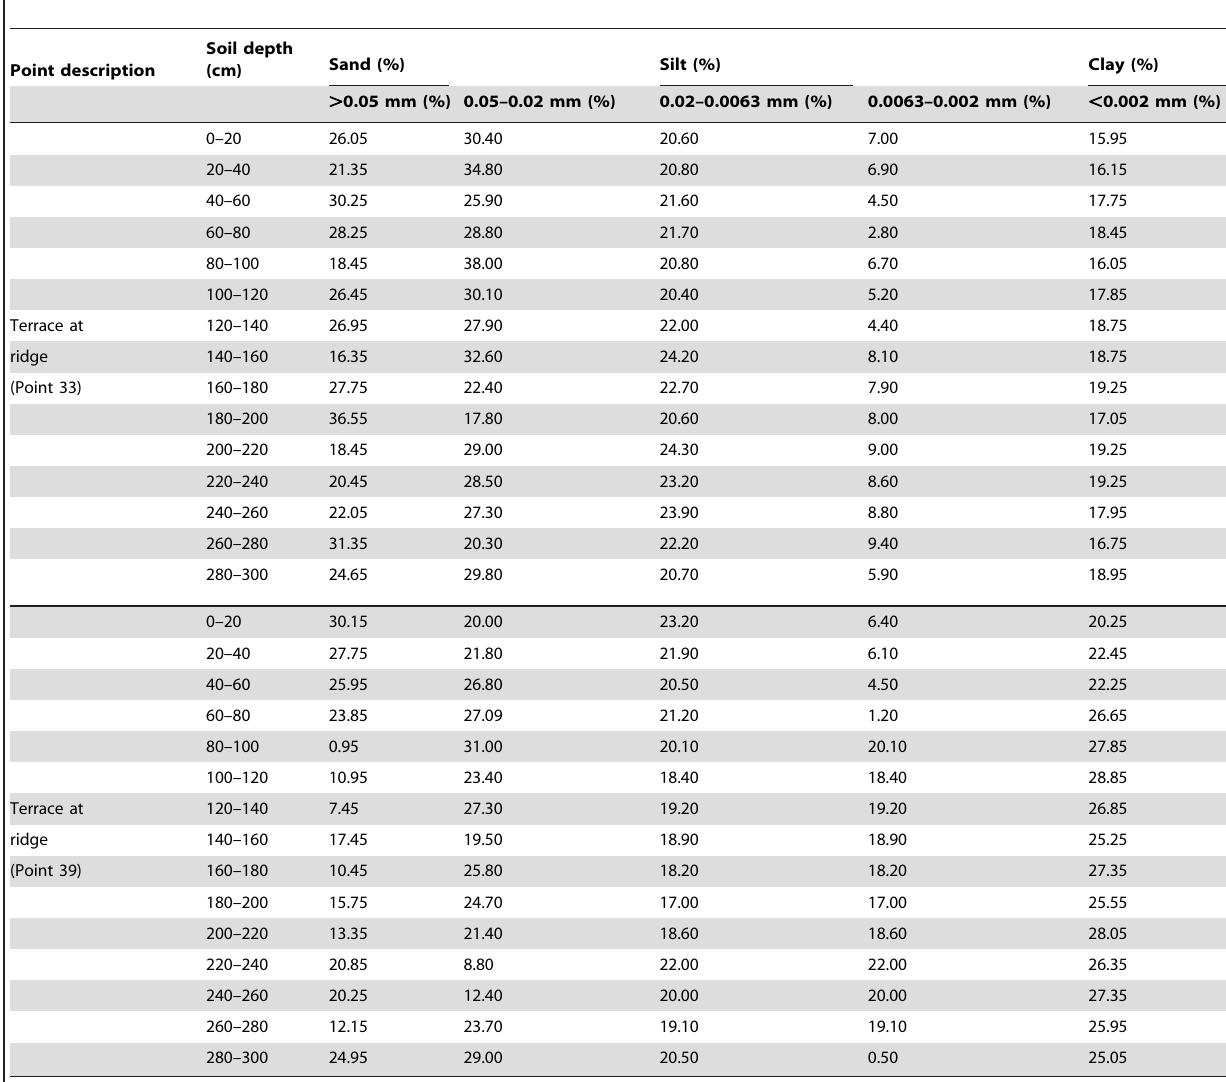
Table 1. Soil texture in vertical profiles related to different landforms in the Sanyanjing catchment in Shanxi province, China.